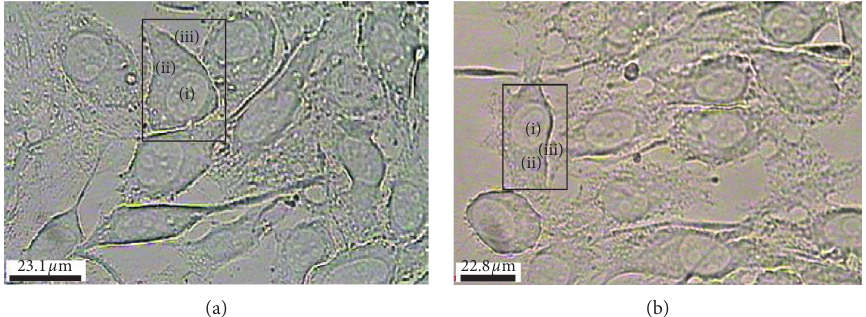
2 ) substrates at 50x magnification,